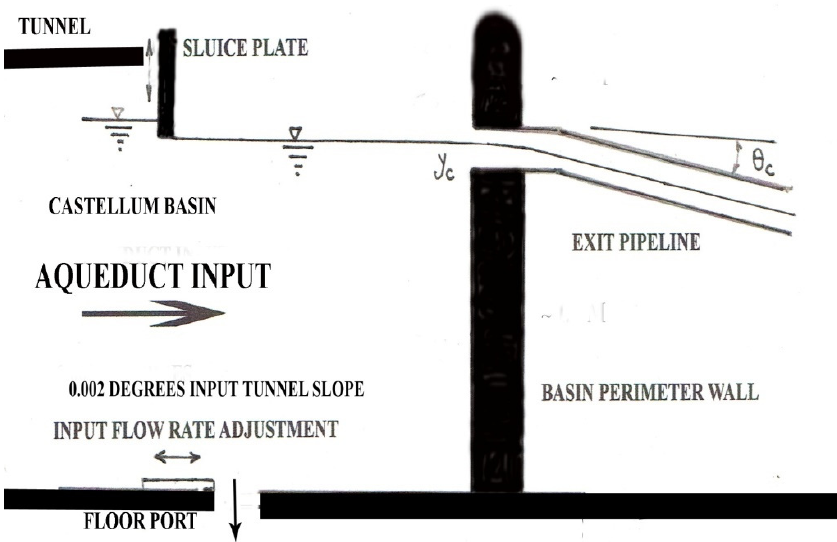
Figure 9. Basin exit wall flow dynamics (not to scale).